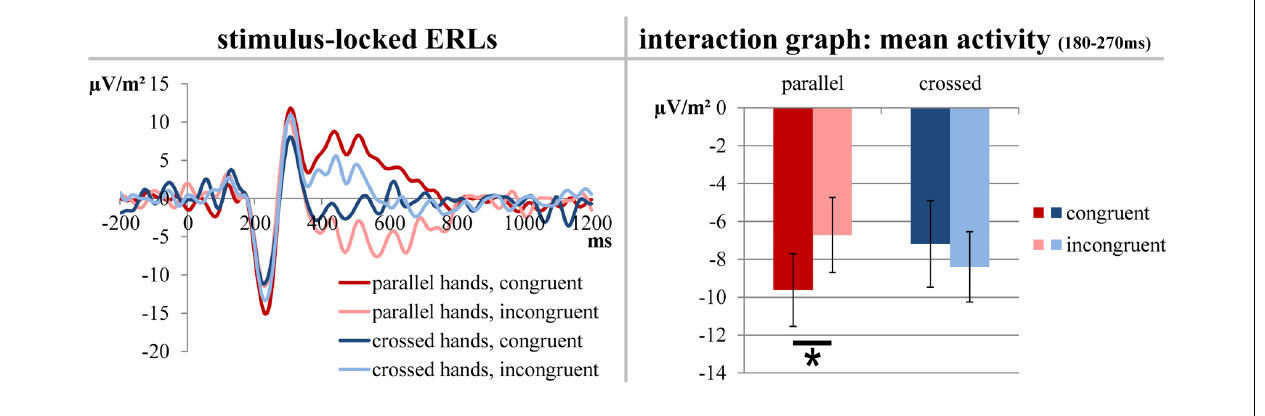
point zero denotes the onset of stimulus presentation. The right part of the figure elucidates the significant differences found between the mean activity values which average the time span from 180 to 270 ms. The error bars indicate the respective SEMs; significant differences are marked with an asterisk.